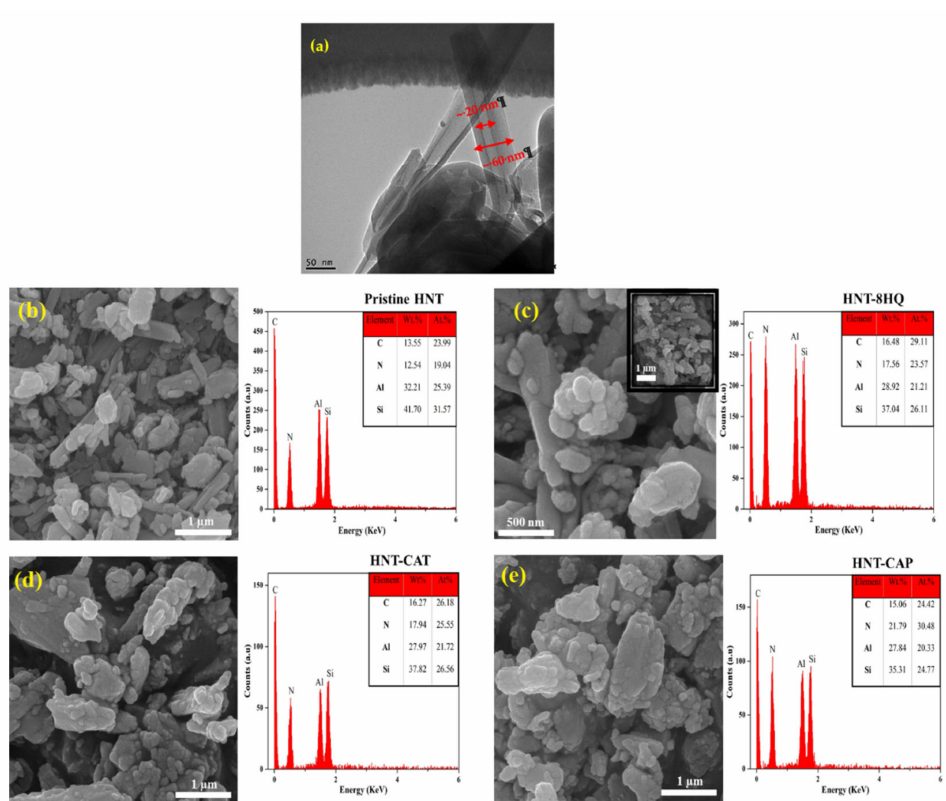
Figure 6. TEM images of pristine HNT ( a ), SEM and EDS of pristine HNT ( b ), 8HNT-8HQ ( c ), HNT-CAT ( d ), and HNT-CAP ( e ) nanoparticles. Red circles inside the images confirm presence of HNTs covered with aniline trimer and pentamer